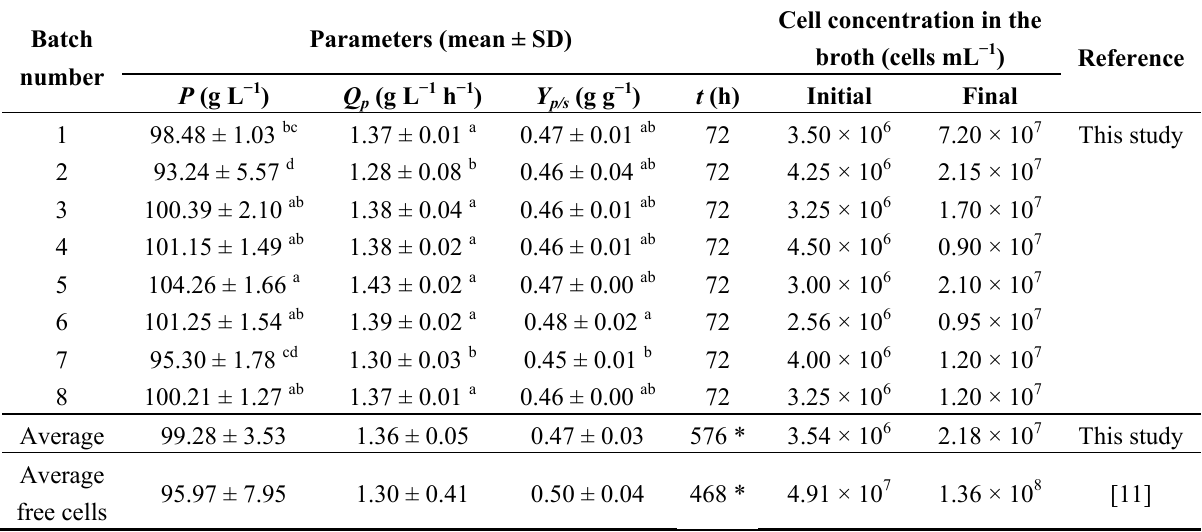
Table 3. Comparison of the fermentation parameters of ethanol production from the sweet sorghum juice by the immobilized cell and free cell systems in the repeated-batch